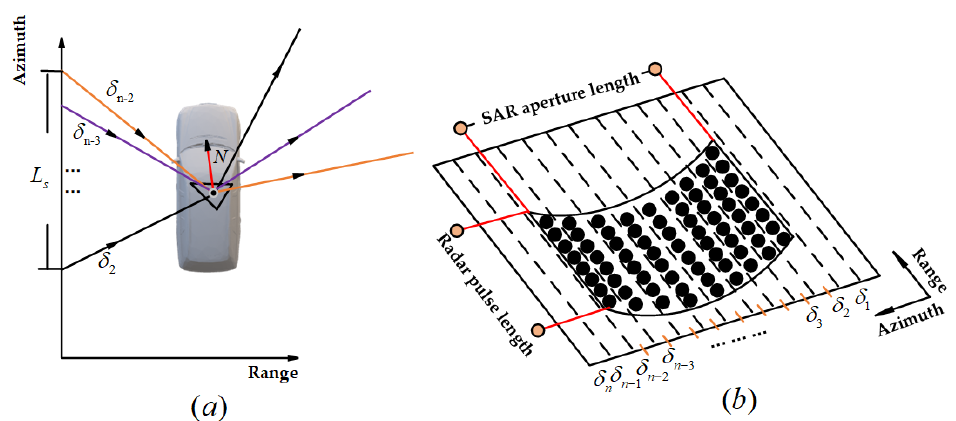
Figure 7. Variation in backscatter coefficient in synthetic aperture: ( a ) the point target corresponds to a certain number of discrete electromagnetic waves, which is usually equal to the number of azimuth sampling points within synthetic aperture time; ( b ) magnitude spatial distribution of point target.